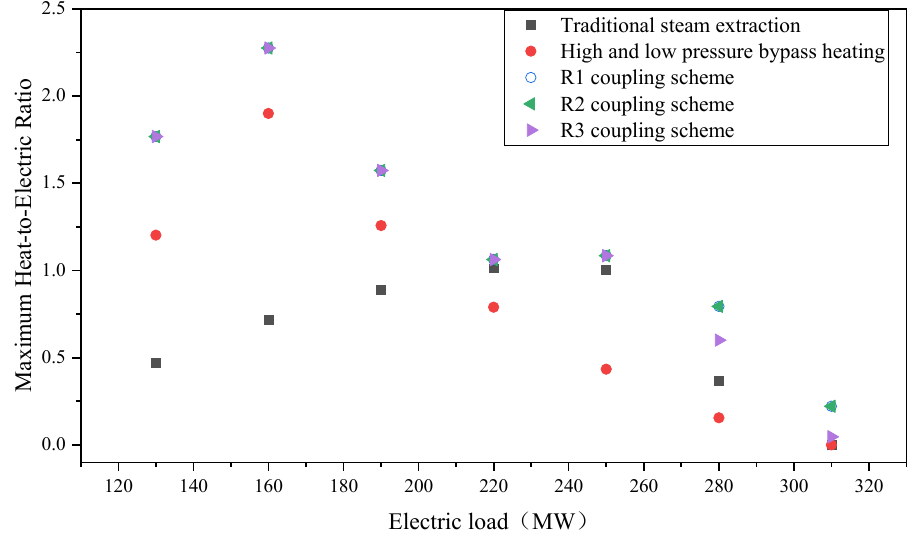
Figure 3. Maximum thermoelectric ratio comparison.